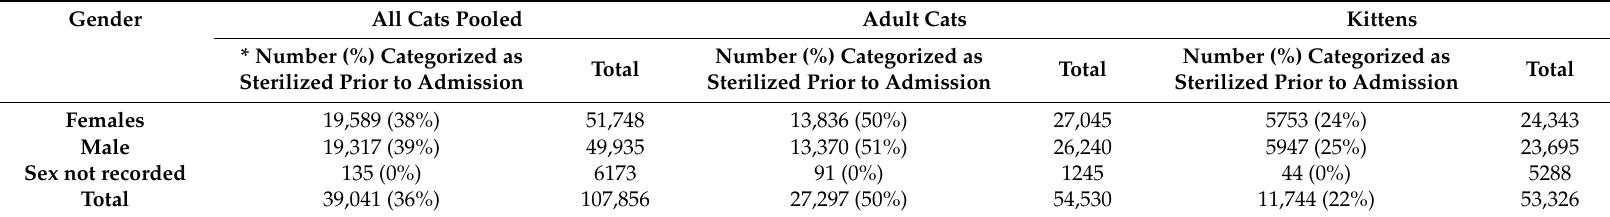
Table 4. Numbers and percentages of admissions to 39 RSPCA shelters between June 2006 and July 2010 where the cat was categorised as having been sterilized prior to admission, by age and gender. Only the 107,856 admissions where sterilization status prior to admission could be determined are